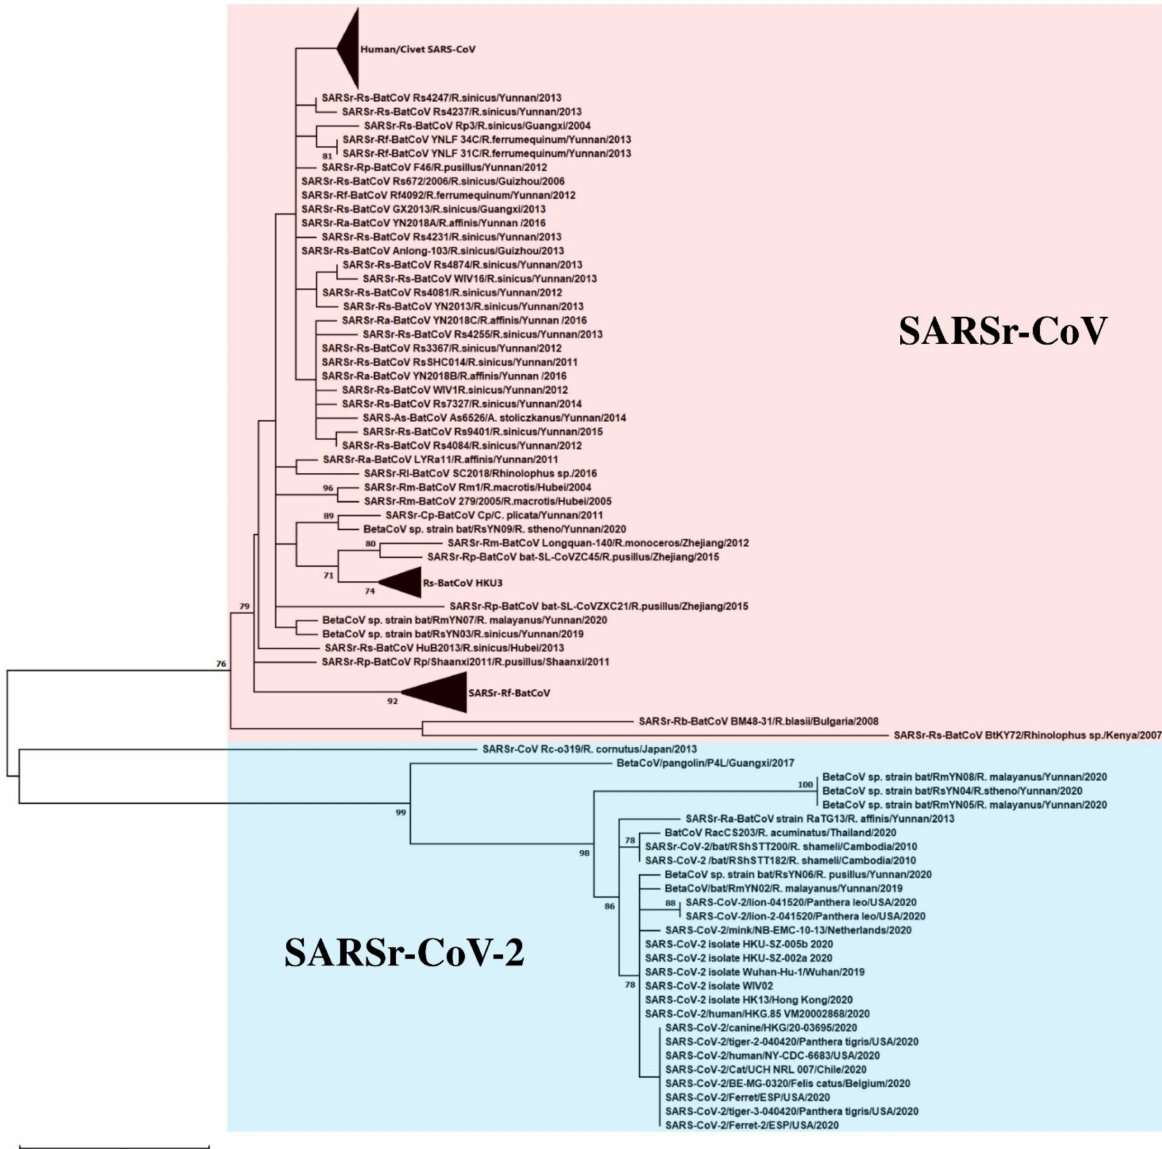
Figure 2. Maximum-likelihood phylogeny based on the nsp12 amino acid sequences of selected SARSr-CoVs. A Jones– Taylor–Thornton (JTT) model of amino acid substitution was used in the analysis with a discrete gamma ( γ ) distribution and the assumption that a certain fraction of sites is evolutionarily invariable (+I). 1000 trees were set for bootstrap values calculation. All bootstrap values and the scale bar indicating the number of amino acid substitutions per site are shown. Viral strains highlighted in red color represents the SARSr-CoV cluster; blue color represents the SARSr-CoV-2